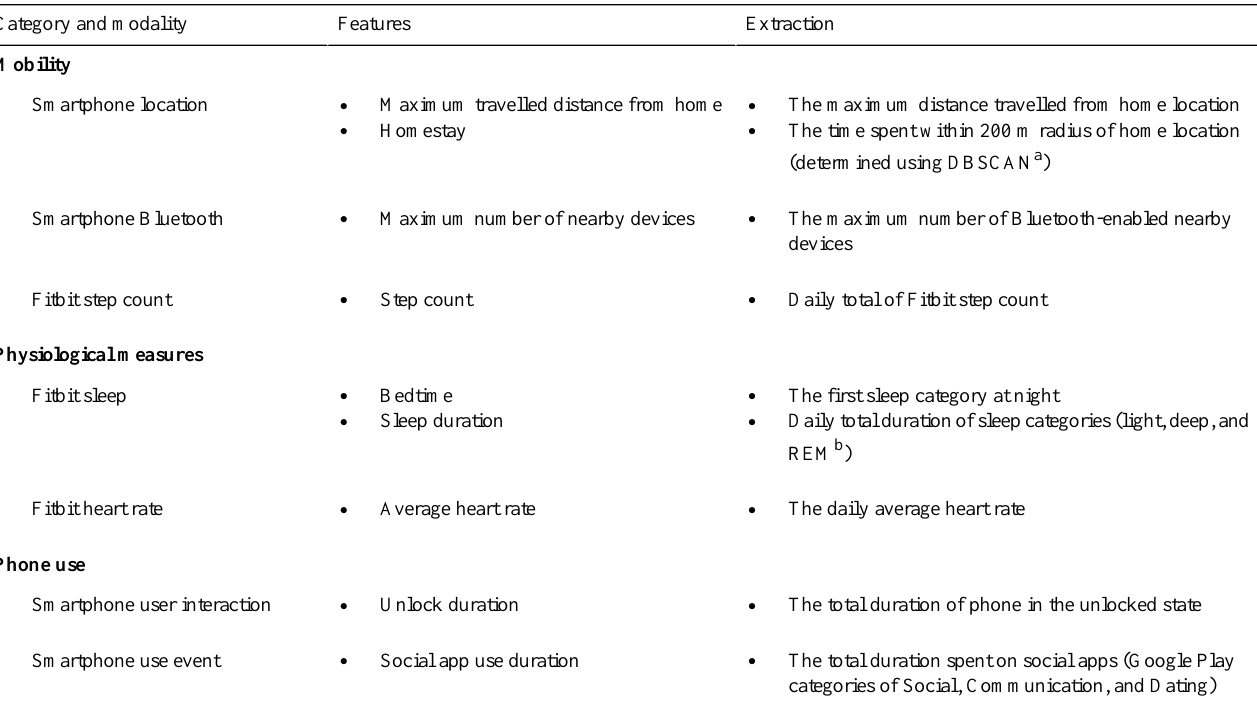
Table 1. A full list of extracted